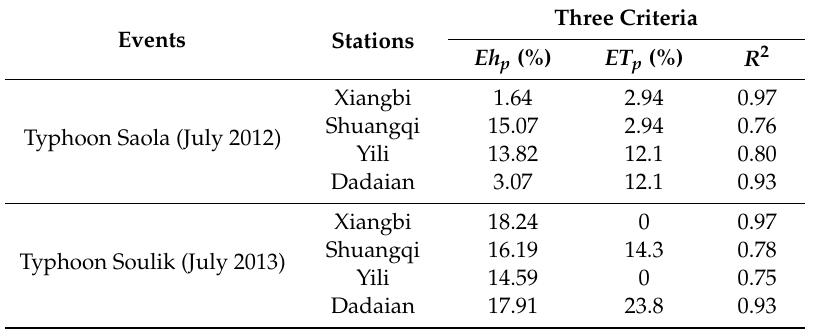
Table 2. Simulated results for three criteria of two flood events obtained using the WASH1D